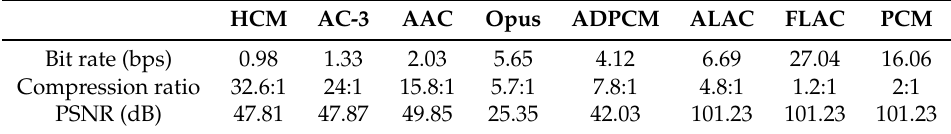
Table 4. Results for Non-linear 2 dataset. Bit rates taken as close as possible to 50dB. HCM AC-3 AAC Opus ADPCM ALAC FLAC PCM Bit rate (bps) 0.98